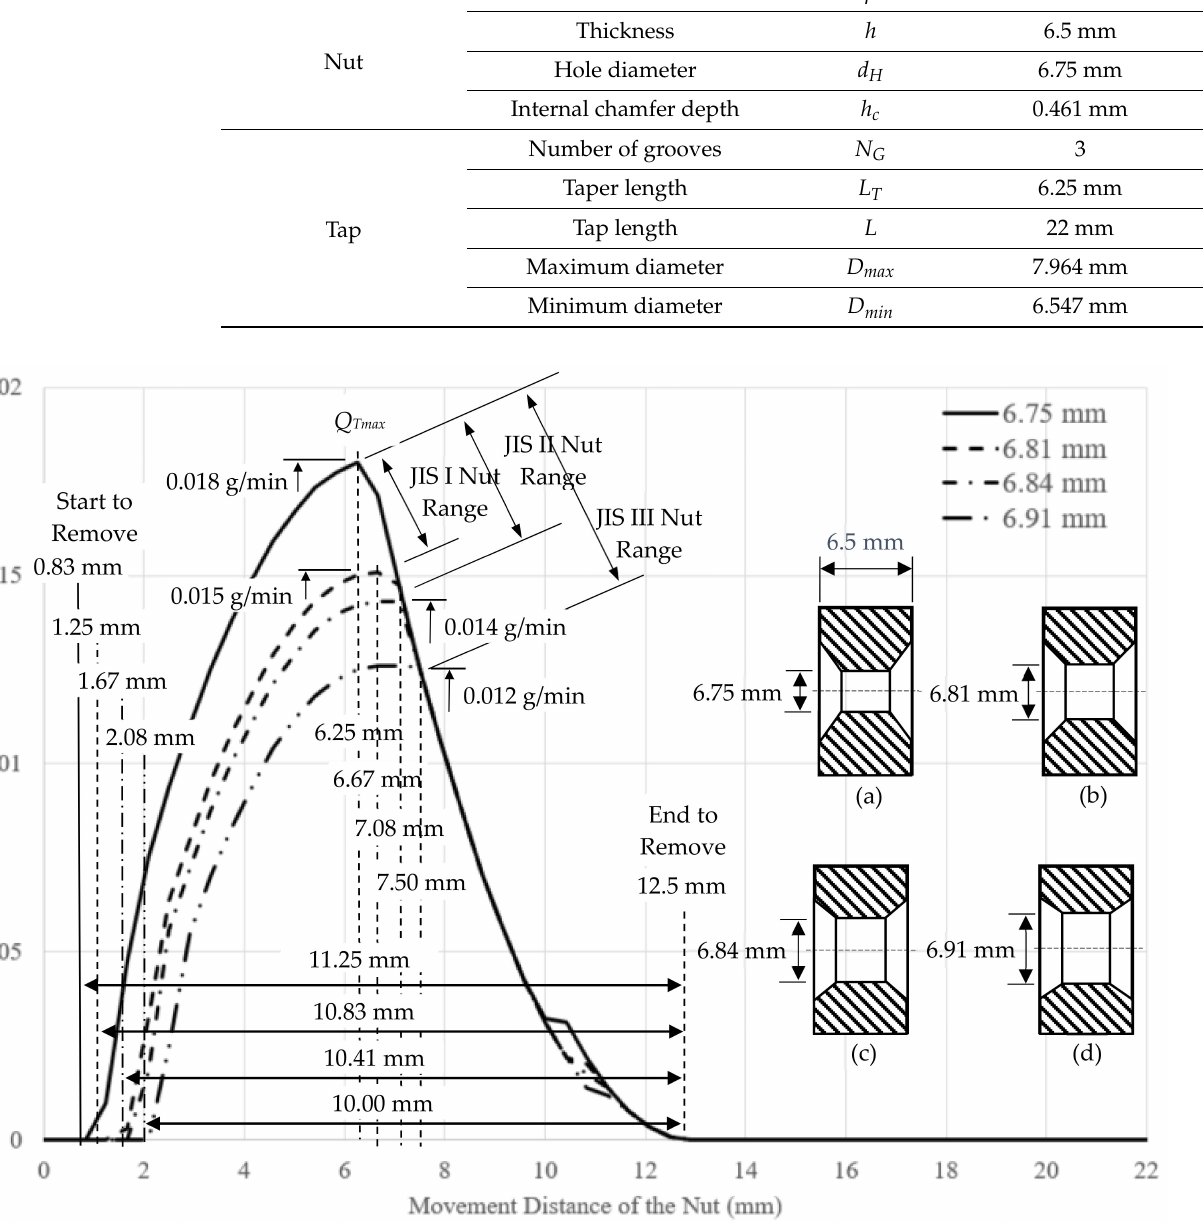
Figure 6. The tapping removal amount in different hole size: ( a ) 6.75 mm; ( b ) 6.81 mm; ( c ) 6.84 mm; ( d ) 6.91